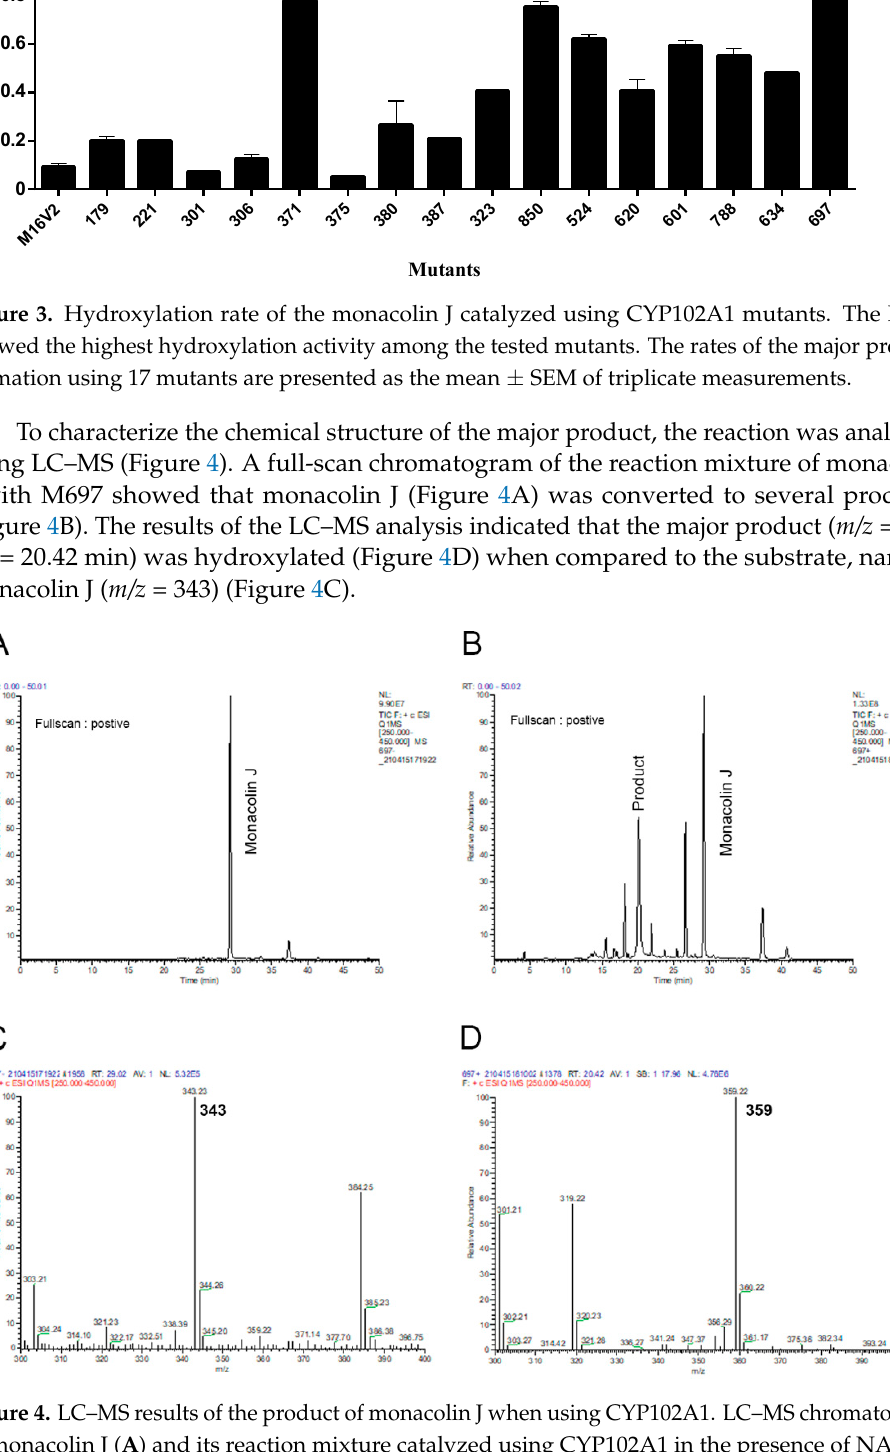
Figure 2. HPLC chromatograms of monacolin J and its products when using CYP102A1 M697. The peaks of the reaction mixtures were identified by comparing their retention times: a major product of monacolin J ( t R = 20.4 min) and monacolin J ( t R = 30.2 min). The star marks the major product.